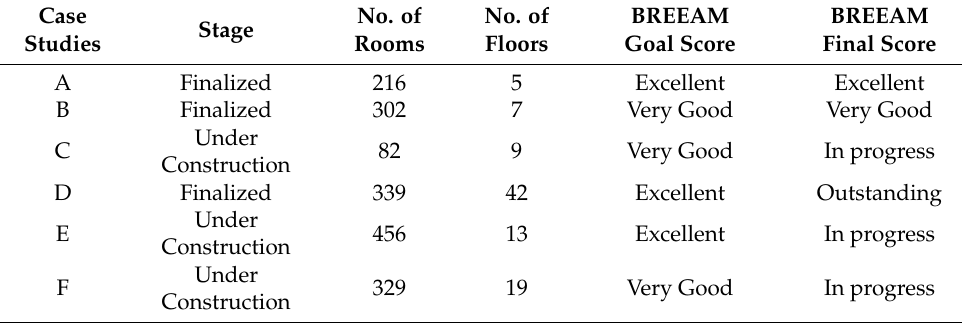
Table 2. Hotels Case